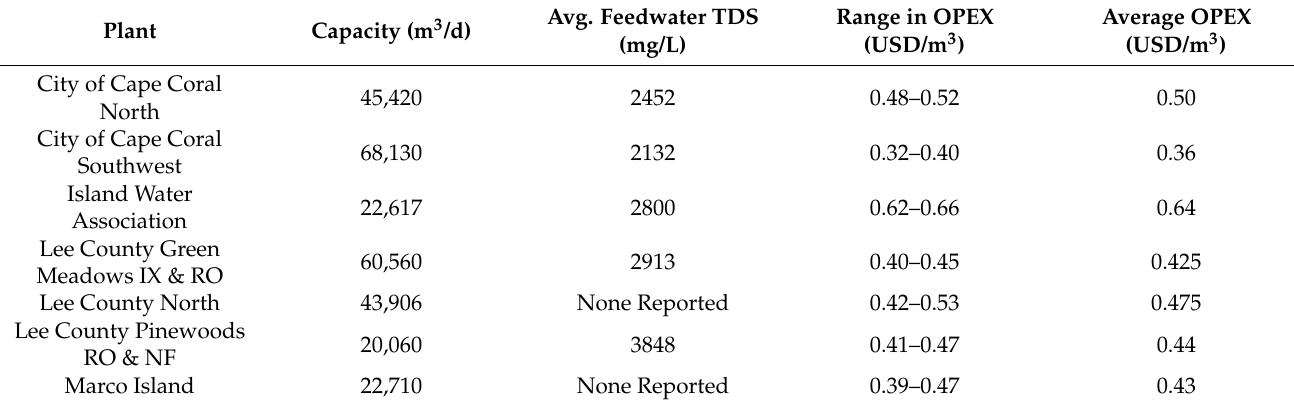
Table 2. Comparison of capacities, feedwater TDS, range in OPEX over 3 years, and average cost over 3 years. Note that the Lee County Pinewoods Plant has less than 3 years of data. Note that the general increase in cost correlates well with the annual rate of inflation of 2%/year.